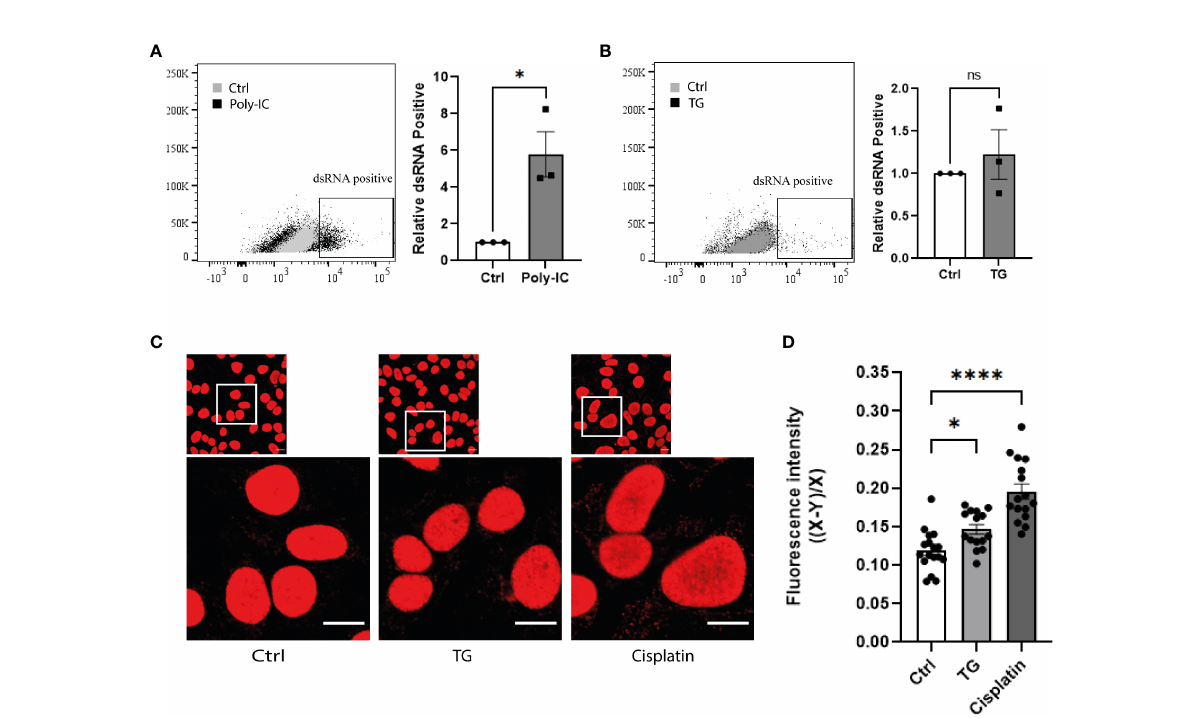
FIGURE 3 ER stress promotes cytosolic accumulation of dsDNA, but not dsRNA, in beta-cells. Flow cytometry analysis of dsRNA accumulation in EndoC- b H1 cells (A) after poly-IC transfection and (B) exposure to TG (0.1µM; 24h). Data are represented by dot plot (left panel) of FACS image and mean ± SEM (n=3) of relative dsRNA positive cells (right panel). (C) Confocal imaging of EndoC- b H1 cells exposed to TG (0.1µM; 24h) or Cisplatin (1µM; 24h), and stained with anti-dsDNA antibody. One represented image out of three independent experiment is shown. Scale =10µm. (D) Quanti fi cation of cytosolic dsDNA expression (20-25 cells per condition). Data are presented as mean ± SEM and statistically analyzed by student ’ s t-test. Signi fi cance is indicated by * P < 0.05, ****P < 0.0001. and ns, not signi fi